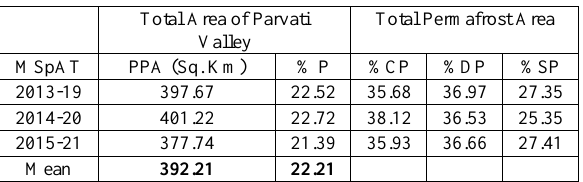
Table 6: The table summarizing the total probable permafrost area (in Sq. Km and %) and the percentage of permafrost area in different categories (CP, DP, SP) using MSpAT for each consecutive years starting from 2013 to 2021.